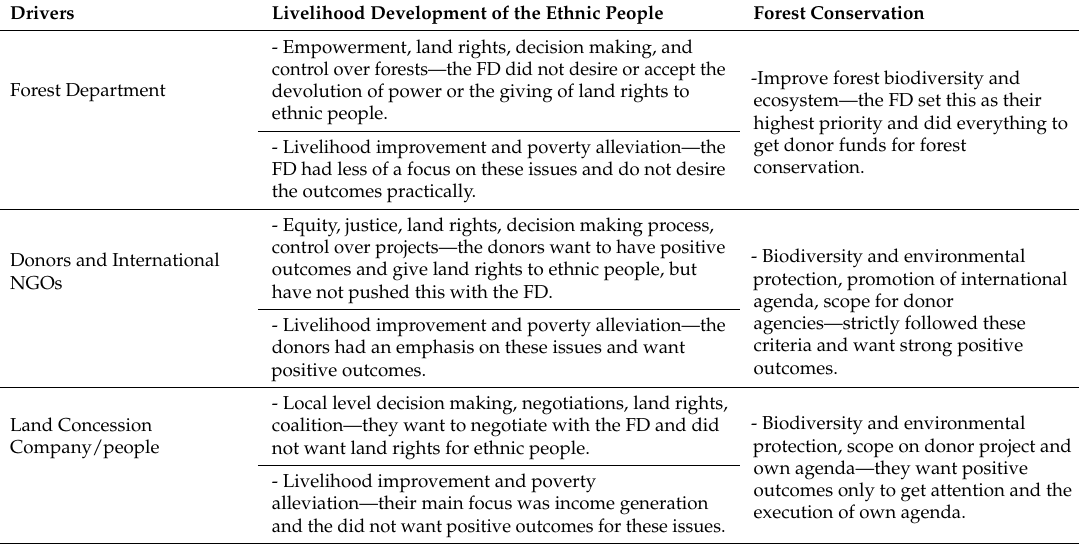
Table 7. Perception of the main drivers towards the development and conservation of ethnic